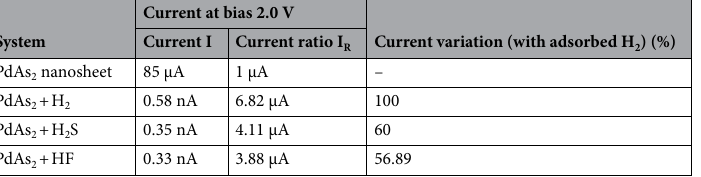
Table 3. The current ratio and current variation of H 2 , H 2 S and HF absorbed PdAs 2 nanosheet at the bias voltage of 2.0 V.